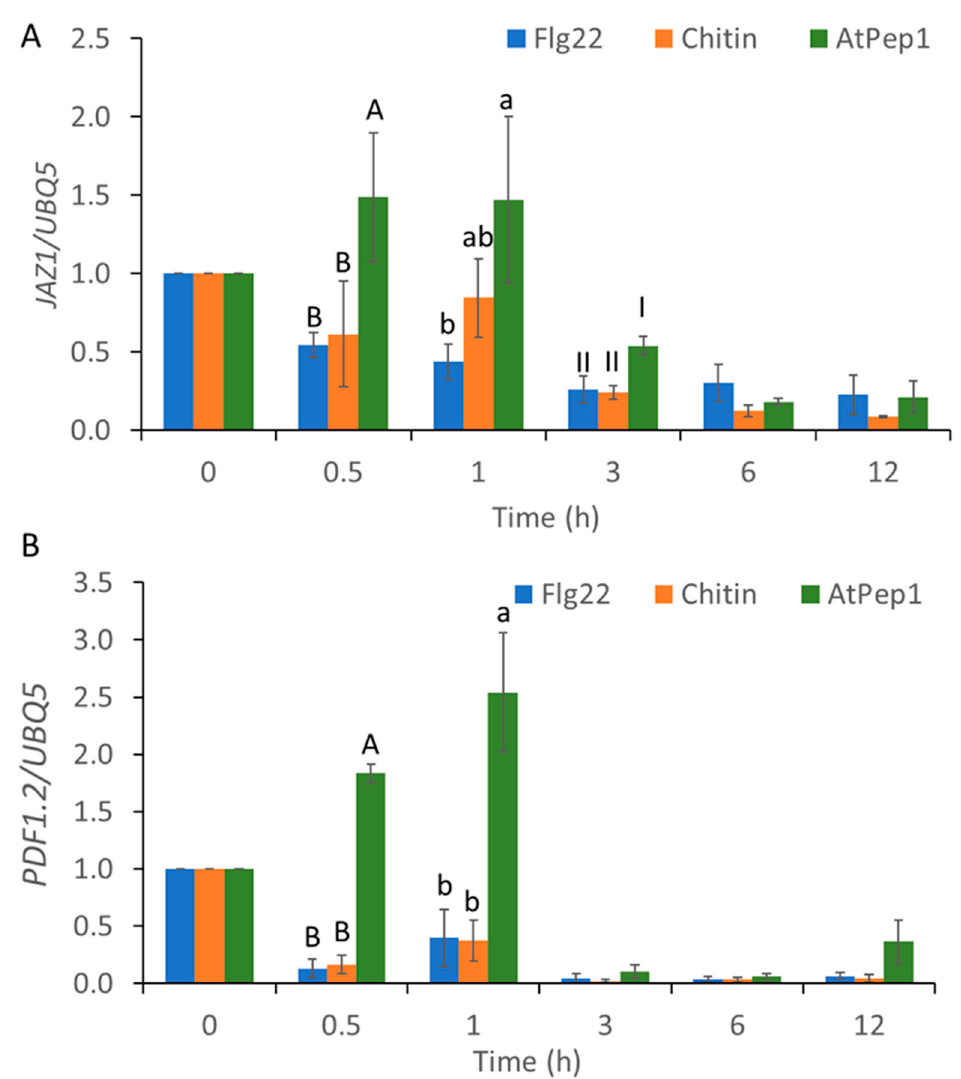
Figure 5. MAMP- and DAMP-induced transcriptional expression of jasmonic acid (JA)-related genes, JAZ1 and PDF1.2 . Fold change in JAZ1 ( A ) and PDF1.2 ( B ) transcript expression in wild-type (WT) Arabidopsis in response to 1 µM of flg22, chitin, and AtPep1 at 0, 0.5, 1, 3, 6, and 12 h after the start of treatment. Total RNA samples were prepared from leaves. JA-related gene expression was normalized to that of the UBQ5 gene. Values were means ± SD of three biological replicates. Different letters indicated statistically significant differences among treatments analyzed by one-way ANOVA ( p < 0.05) with Tukey test.